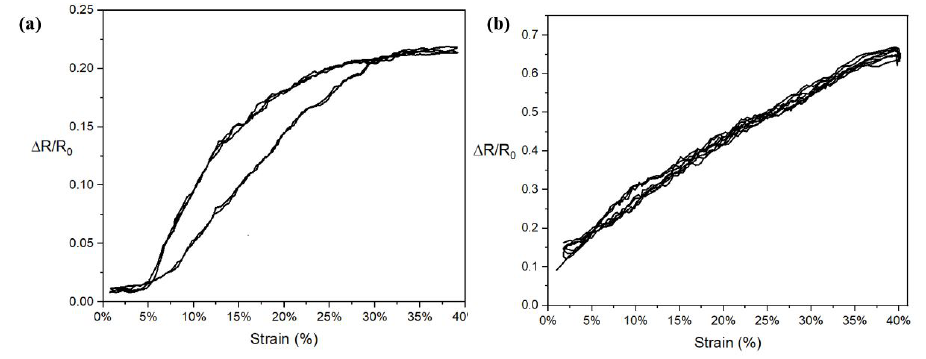
Figure 9. The two different results of samples knitted with conductive outside ( a ) NP 9 Y S 1 C 2 E 1 CO and conductive inside ( b ) NP 9 Y S 1 C 2 E 1